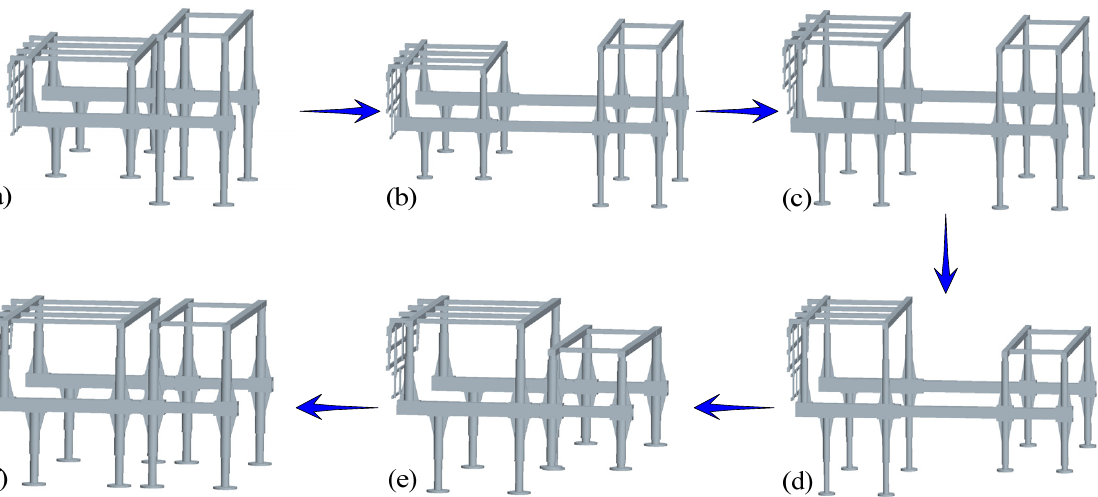
Figure 2. Working process of the new type of HAAS for fully mechanized roadways. ( a ) Support preparation; (b ) Front support movement; ( c ) Front support expansion; ( d ) Rear support retracted;